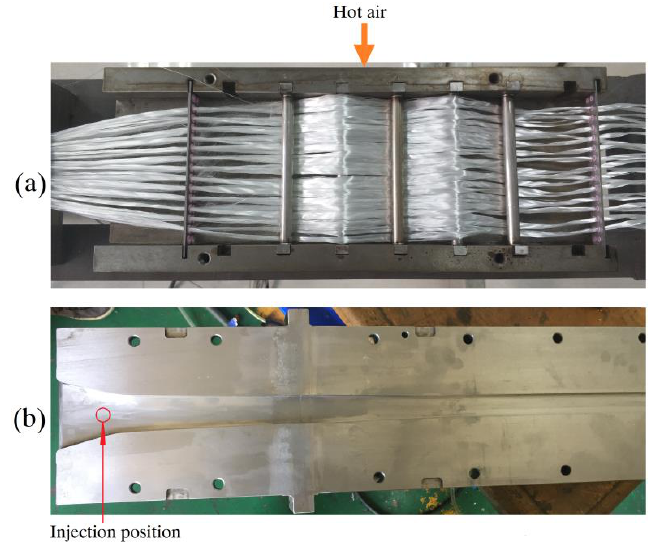
Figure 4. Components of the pultrusion line: ( a ) fibers preheating and arranging unit, and ( b ) the upper part of the pultrusion die.